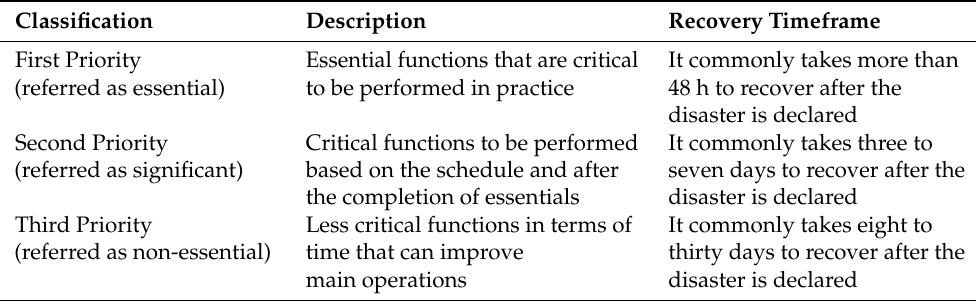
Table 1. Classifications to prioritize business processes in continuity planning